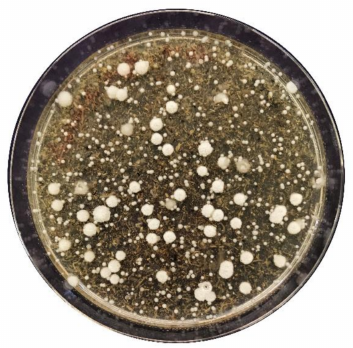
Figure 1. Yeast isolation on an agar plate using a modified YEPD medium. Yeast isolation from different antagonists’ sources was carried out in a modified YEPD medium added with lemon dehydrated peel powder and lemon essential oil (YEPD-CITRUS). Selection was based on different morphological appearances, and they were examined under bright-field microscopy to confirm yeast morphology.